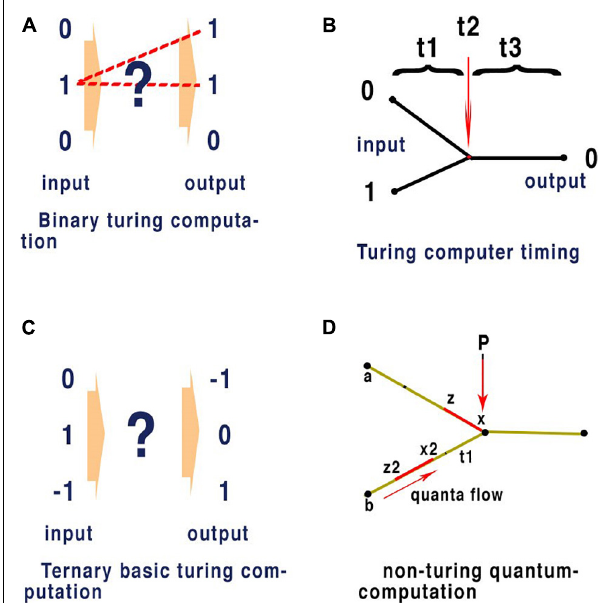
FIGURE 5 | In quantum computation network timing does not require an external clock. This form of computation only requires input to reflect consistent outputs for given values and here we compare it with Turing computation where clock speed synchronises input with output. Panel (A) is an illustration of conventional binary computation of inputs and outputs. The exact network that separates the input from the output is indicated by (?) and the most obvious pathways are shown as dotted lines and gating within the network (?), forms this pathway. This gating represents a single command and must be executed within the set time allocated between the input and output as defined by some external clock. (?) May represent a complex network, flow through the network is defined node to node by precise timing between those nodes in exactly the same way and the outputs are always synchronised